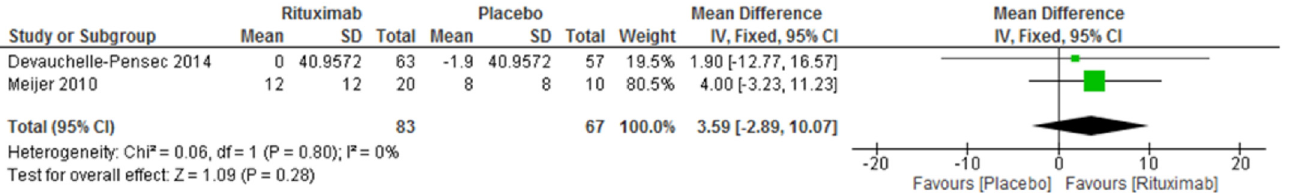
Fig 3. Rituximab X Placebo. Meta-analysis of the outcome Schimer test at week 24.